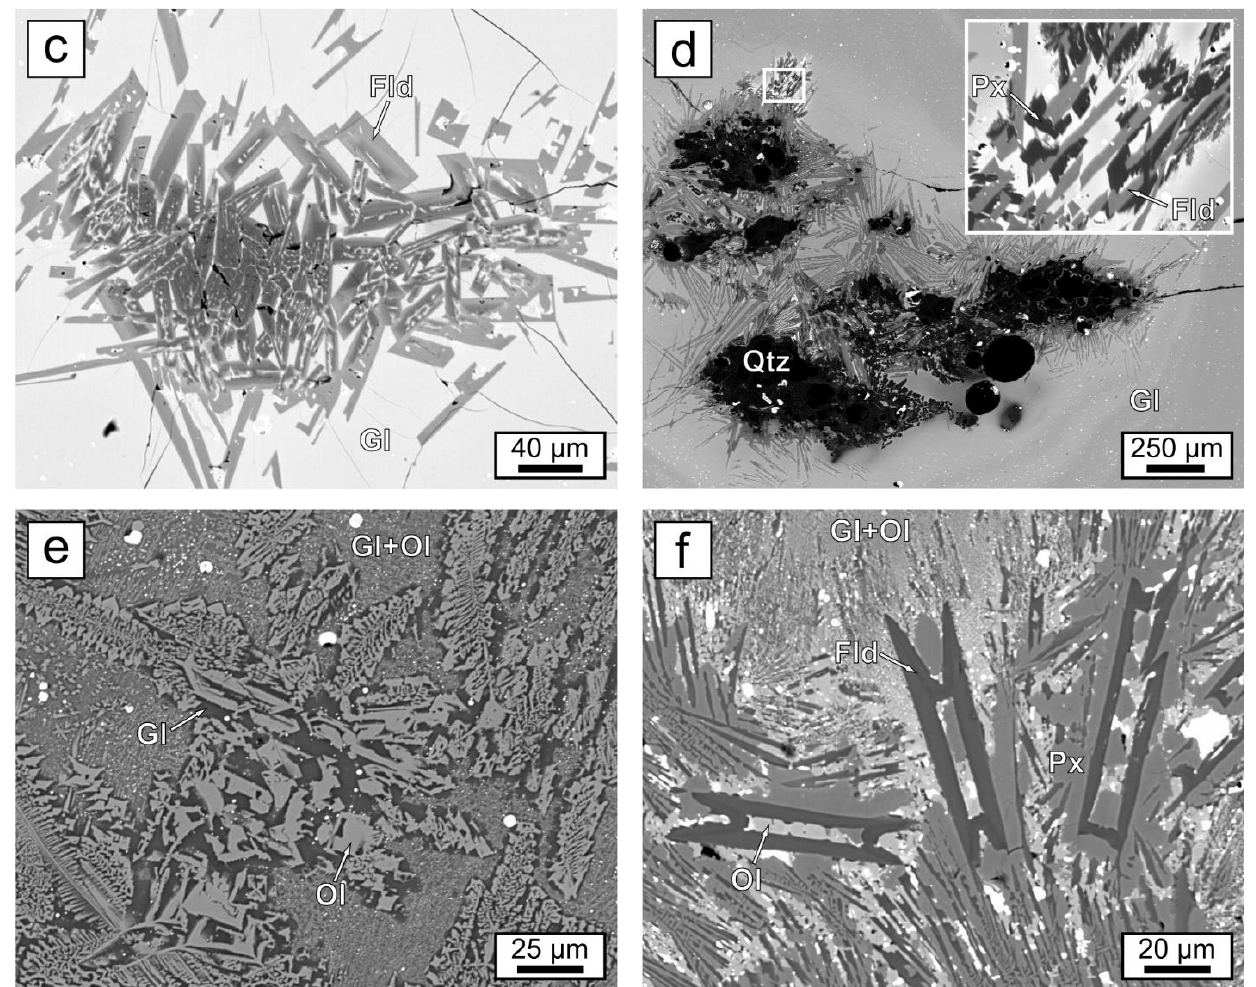
Figure 4. Images in transmitted parallel polarized light ( a ) and BSE (the rest) of A ( a – d ) and B (the rest) Type slags from the studied localities. ( a ) aggregate of feldspars (Fld) surrounded by yellowish-green glass with fluidal texture (Gl) (CP4); ( b ) zonation of feldspars and surrounding glass, secondary baryte (Brt) inside pore (ML25); ( c ) distinctive zonation of feldspars on the level of a whole aggregate (ML24); ( d ) long laths of feldspar and short columns of pyroxene (Px) crystalized around quartz relicts (Qtz) (JS6); ( e ) two generations of olivine (PL8); ( f ) slightly zoned feldspar laths surrounded by pyroxene and olivine (PL15). Po — pyrrhotite, Gl — glass. The olivine from Site 2 is quasi-pure fayalite (87 – 96 mol.%), marginally substituted on average by 4 mol.% of forsterite. The contribution of other endmembers is low, not exceeding 3 mol.%. The main difference in olivine composition between given localities narrows to higher contents of ZnO and MnO for Site 1, as can be seen from the ternary plots (Figure 5a,b). Olivines from Site 1 are also on average richer in MgO. The presence of up to 1.78 wt.% of Al 2 O 3 , 0.54 wt.% of BaO, 0.46 wt.% of PbO and 0.67 wt.% of K 2 O in point analyses could be addressed by sub-microscopic inclusions of glass